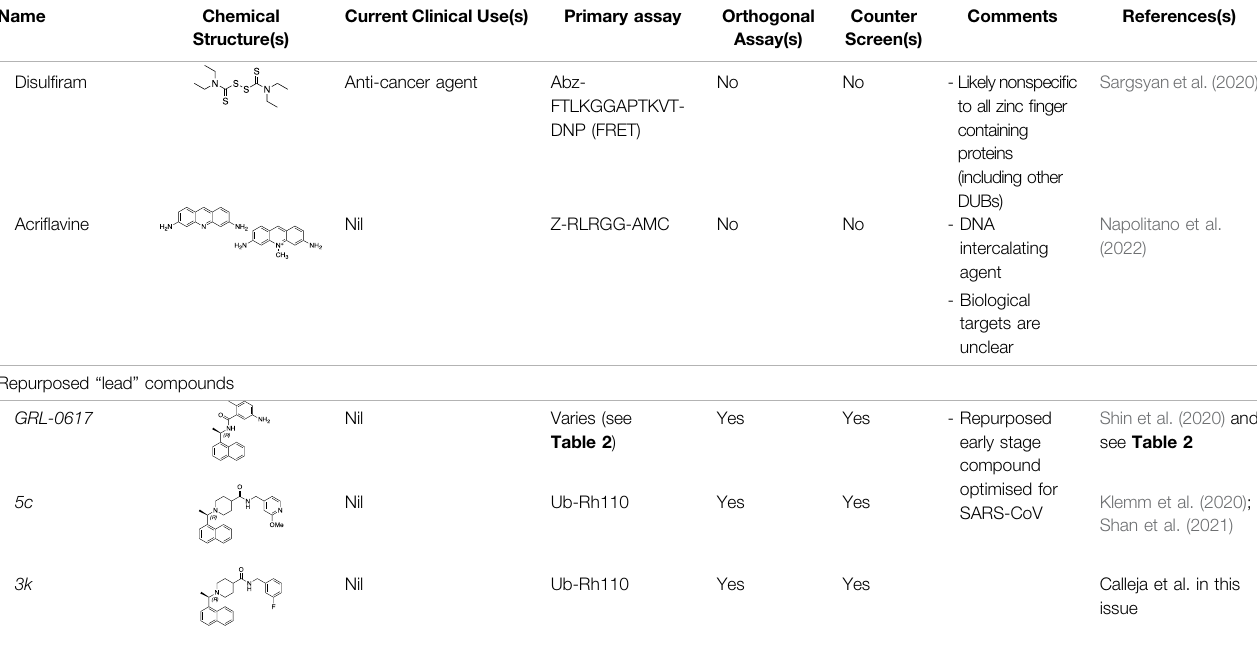
TABLE 1 | ( Continued ) Summary of reported drug repurposing attempts against SARS-CoV-2